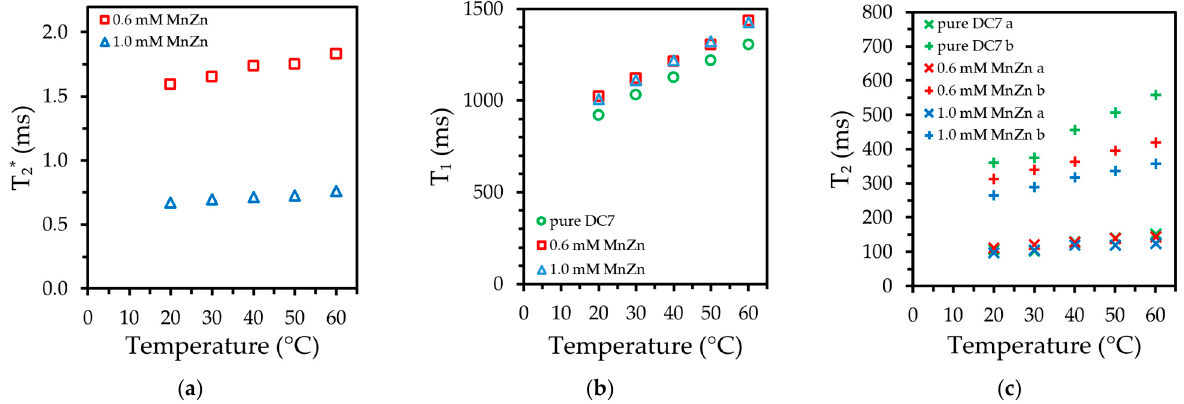
Figure 7. Temperature dependence of nuclear relaxation times of silicone protons at 3.0 T. ( a ) spin 2* , ( b ) spin–lattice time T dephasing time T 2* , ( b ) spin–lattice time T 1 , ( c ) spin–spin time T 2 . dephasing time T 1 , ( c ) spin–spin time T 2